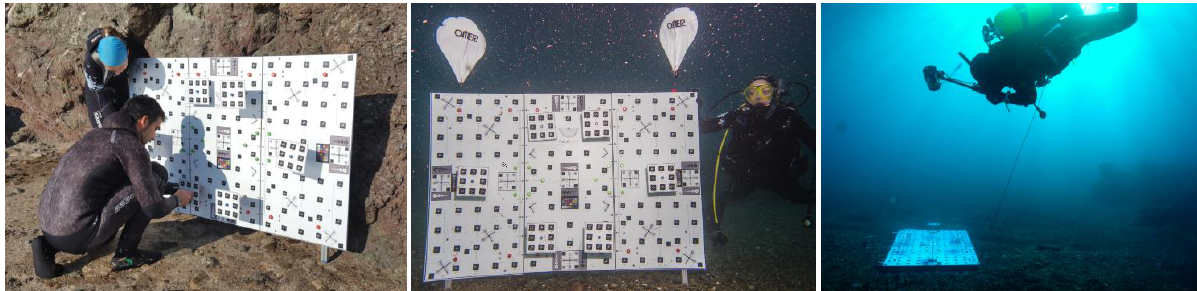
Figure 5. The testfield used for underwater calibrations during the assembly (left) and image acquisition (center and